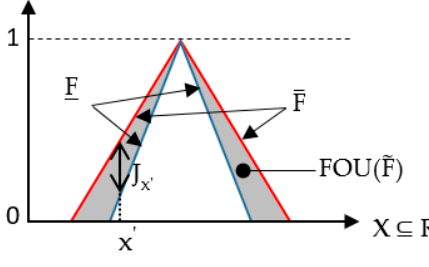
Figure 1. An interval type-2 fuzzy set F (cid:3560) .